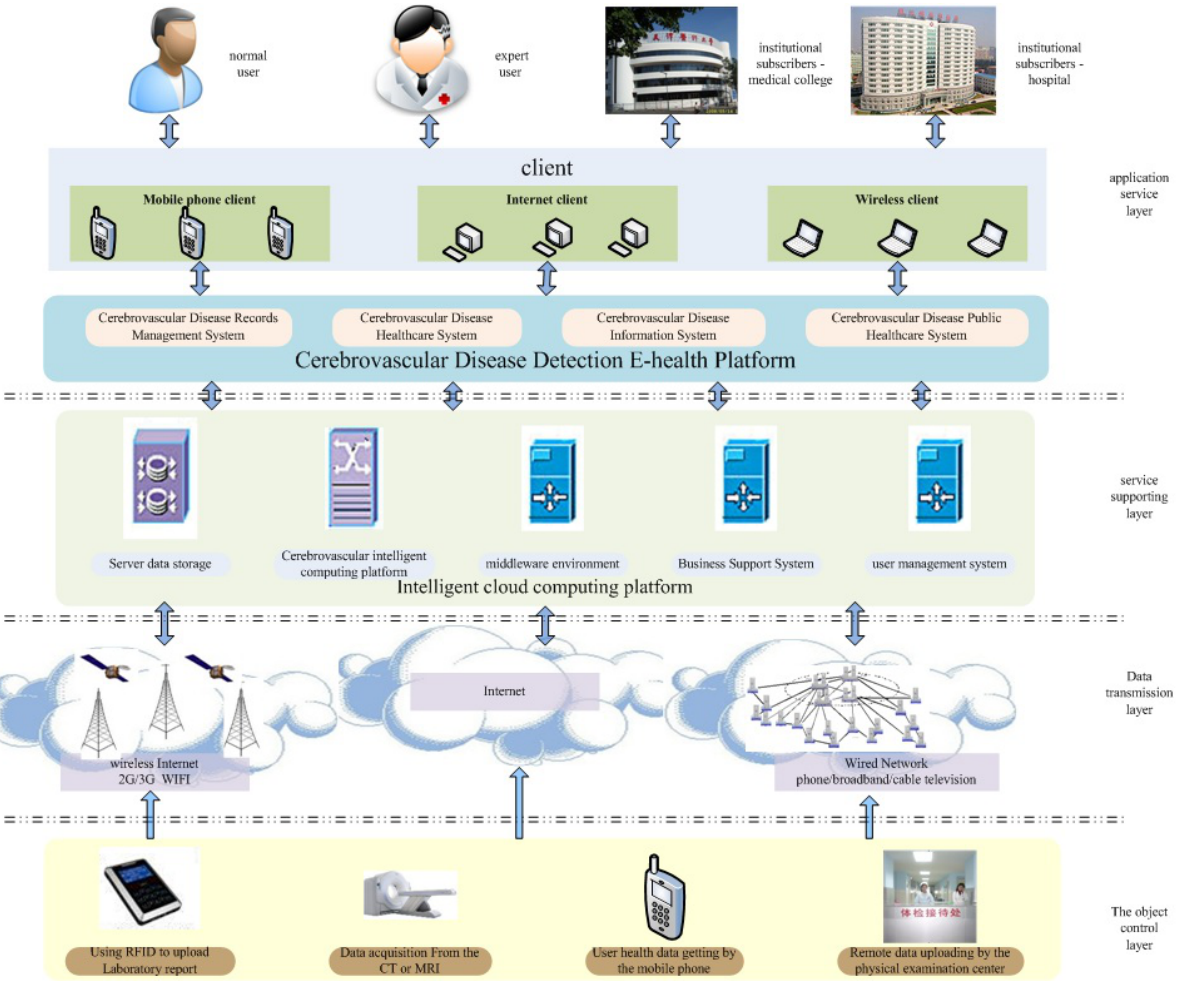
Figure 1. The hierarchy of the Internet of things eHealth platform about cerebrovascular